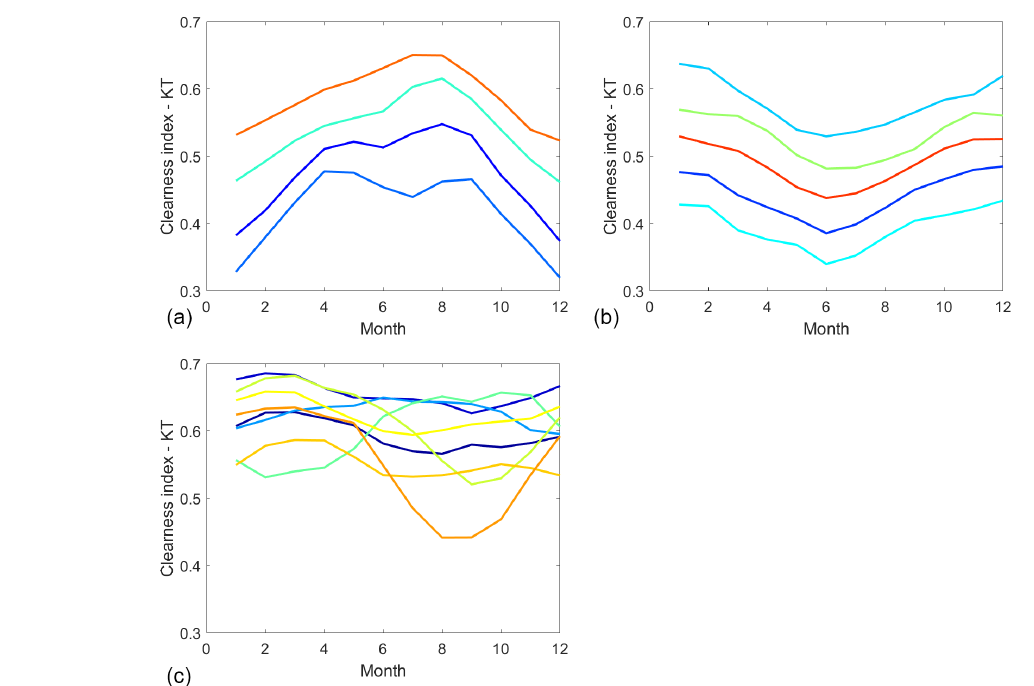
Figure 7. Typical profiles of KT for each class. Colours are the same as those in Fig. 6a. 4 northernmost classes (a) , 5 southernmost classes (b) , 8 tropical classes (c) .